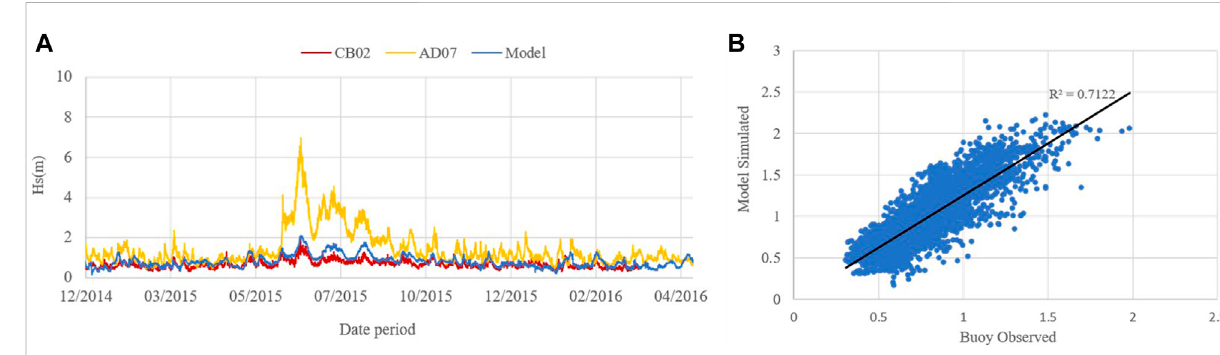
FIGURE 6 Comparison of signi fi cant wave height between the modelled data and measured data at CB02 location (A) Time series of signi fi cant wave height (B) Scatter plot between model simulated and observed buoy CB02 data.